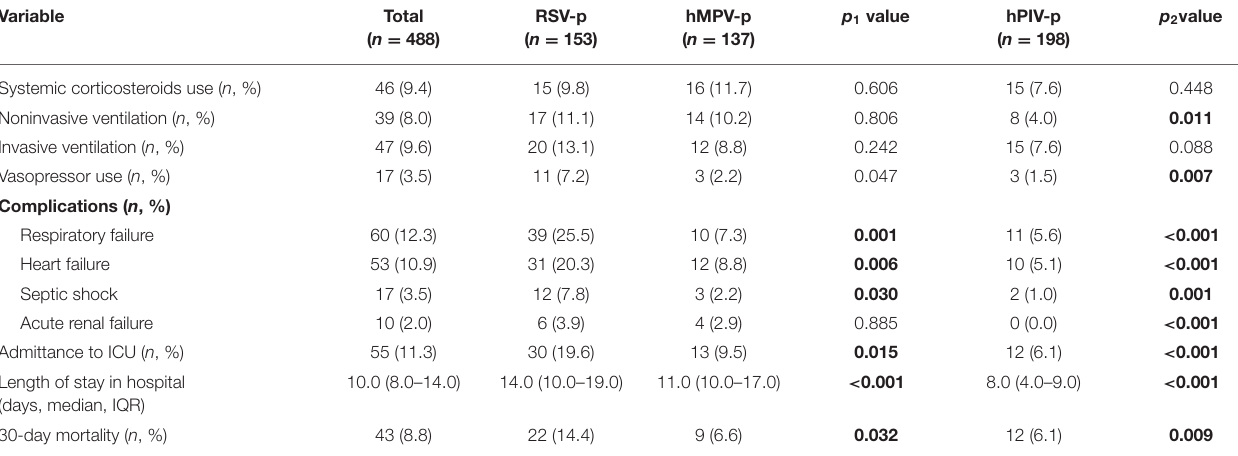
TABLE 2 | Clinical management and outcomes of patients with three types of PMVs-p.